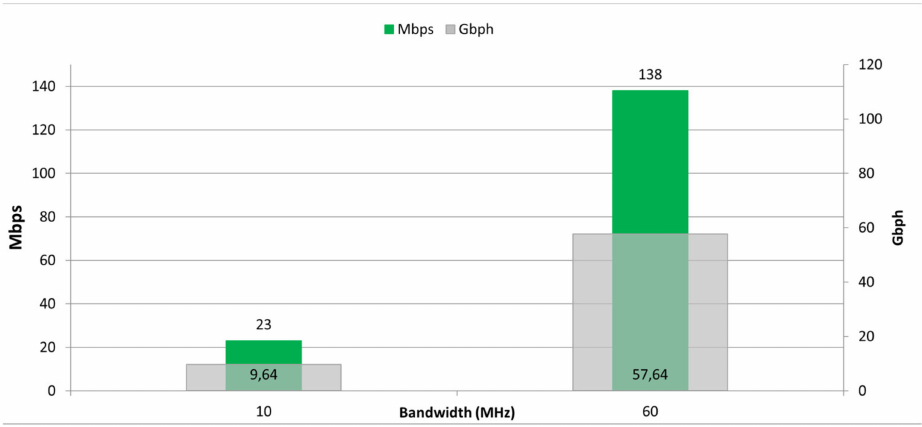
Figure 2. Average capacity 5G cells on the deployed